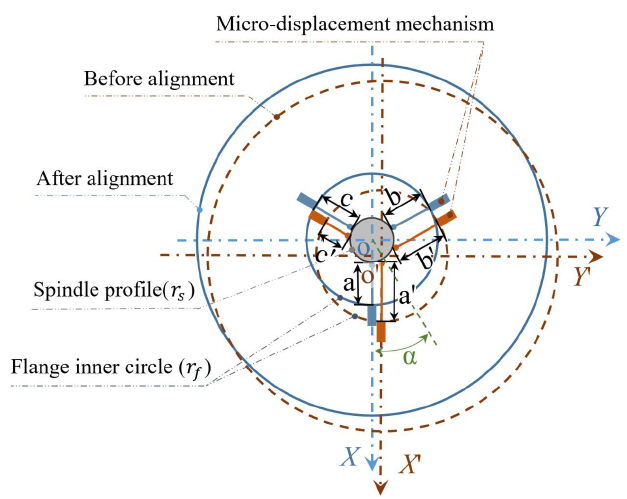
Figure 2. Schematic diagram of three-way alignment. The circumferential contour before self-aligning is shown as the dashed line, and the circumferential contour after self-aligning is shown as the solid line. Defining r in Equation (3) is equal to the spindle radius r s and the flange inner circle radius r f , respectively. The position points of the three micro-displacement mechanisms in contact with the spindle before self-aligning can be obtained as 𝐴 (cid:3046)(cid:4593) (𝑥 (cid:3028)(cid:3046)(cid:4593) , 𝑦 (cid:3028)(cid:3046)(cid:4593) ), 𝐵 (cid:3046)(cid:4593) (𝑥 (cid:3029)(cid:3046)(cid:4593) , 𝑦 (cid:3029)(cid:3046)(cid:4593) ), 𝐶 (cid:3046)(cid:4593) (𝑥 (cid:3030)(cid:3046)(cid:4593) , 𝑦 (cid:3030)(cid:3046)(cid:4593) ) . The position points of the three micro-displacement mechanisms in contact with the inner circle of the flange before self-aligning can be obtained as 𝐴 (cid:3033)(cid:4593) (𝑥 (cid:3028)(cid:3033)(cid:4593) , 𝑦 (cid:3028)(cid:3033)(cid:4593) ), 𝐵 (cid:3033)(cid:4593) (𝑥 (cid:3029)(cid:3033)(cid:4593) , 𝑦 (cid:3029)(cid:3033)(cid:4593) ), 𝐶 (cid:3033)(cid:4593) (𝑥 (cid:3030)(cid:3033)(cid:4593) , 𝑦 (cid:3030)(cid:3033)(cid:4593) ) . The length of the three micro-displacement mechanisms before self-aligning is 𝑎 (cid:4593) =